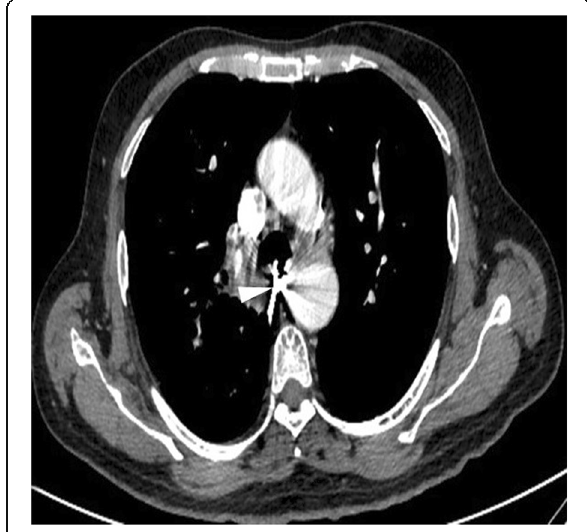
Fig. 4 Post embolization and foreign body dis-impaction axial CT image, showing metallic artifact from recent bronchial artery pseudoaneurysm embolization (white